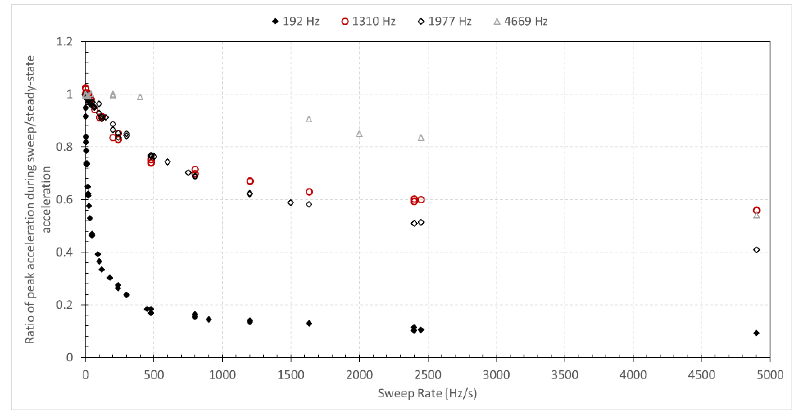
Figure 5. Ratio of the peak acceleration during sweep tests on the acceleration in steady-state